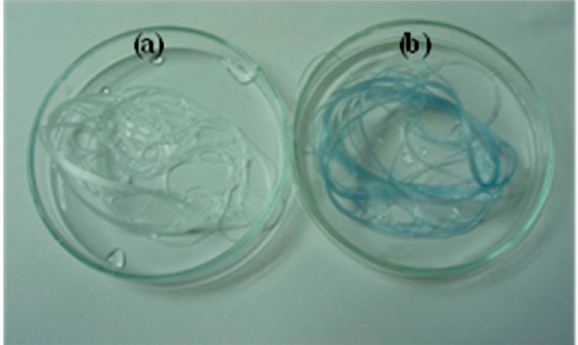
Figure 3. PLA fibers stained with amido black 10B: ( a ) original PLA fiber and ( b ) CS–PLA